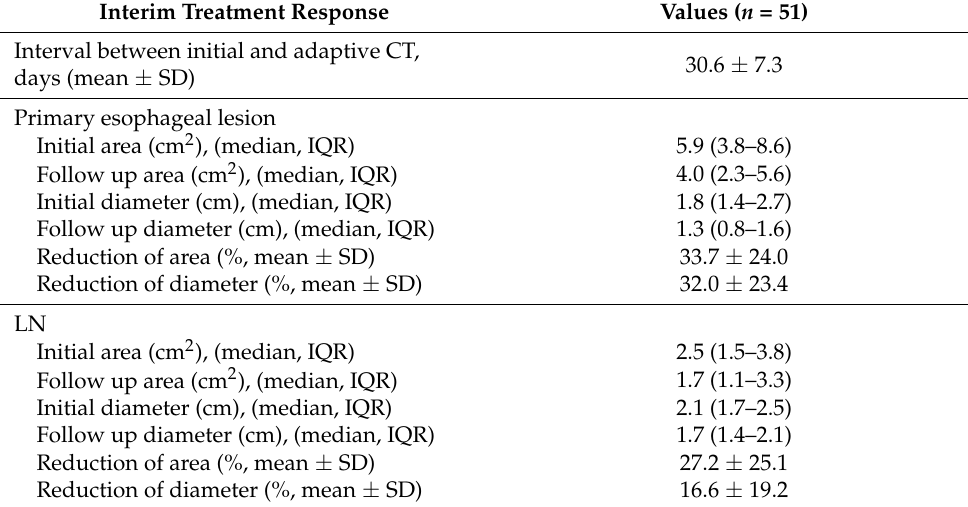
Table 2. Interim treatment response from the comparison between initial and adaptive CT